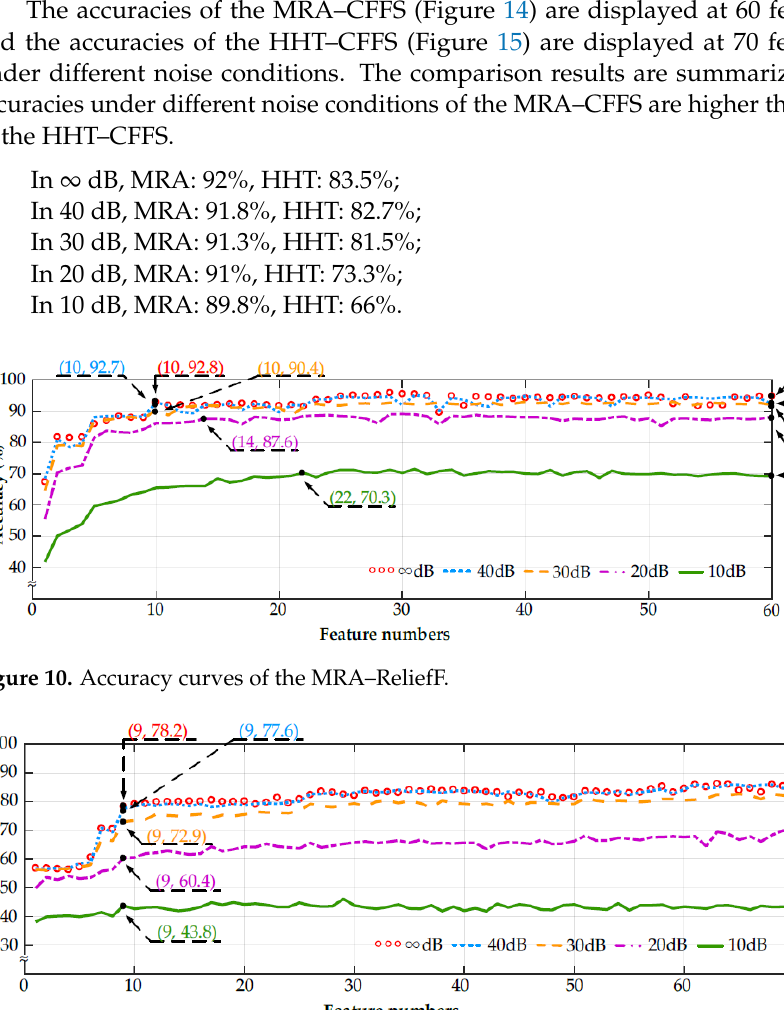
Figure 11. Accuracy curves of the HHT–ReliefF.